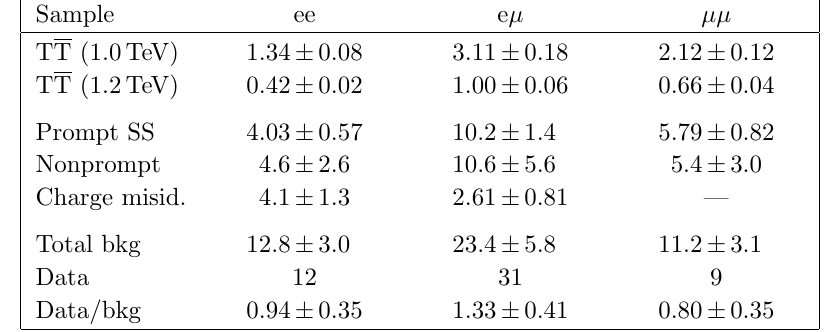
Table 6 . Numbers of predicted and observed events for lepton (cid:13)avor categories in the same- sign dilepton channel before the (cid:12)t to data. Uncertainties include both statistical and systematic